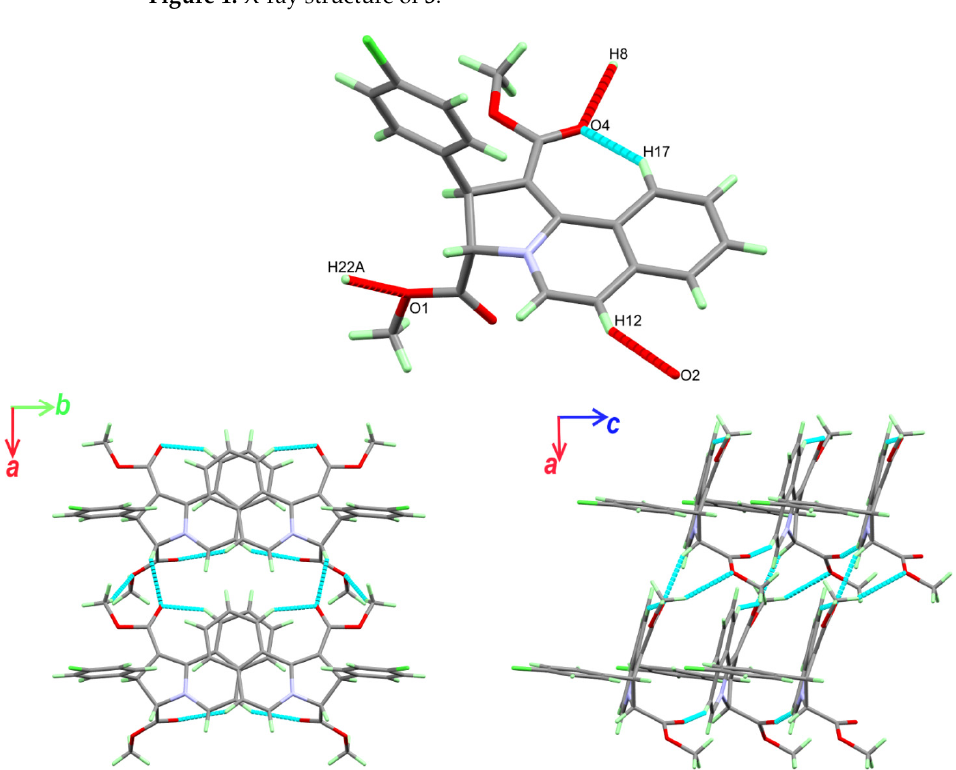
Figure 2. Hydrogen bonds in 3 . The molecular packing of 3 is dominated by three hydrogen bonds shown as red dotted lines in Figure 2 (left part). The molecules are packed via non classical C-H…O interactions such as C8-H8...O4, C12-H12...O2, and C22-H22A...O1 contacts. The distances between the donor (D) and acceptor (A) are 3.245(2), 3.346(2) and 3.520(2) Å, respectively (Table 3). The molecular packing is shown in Figure 2 (right part).